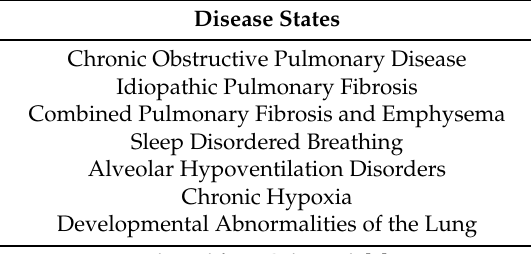
Table 1. Disease states associated with group III pulmonary